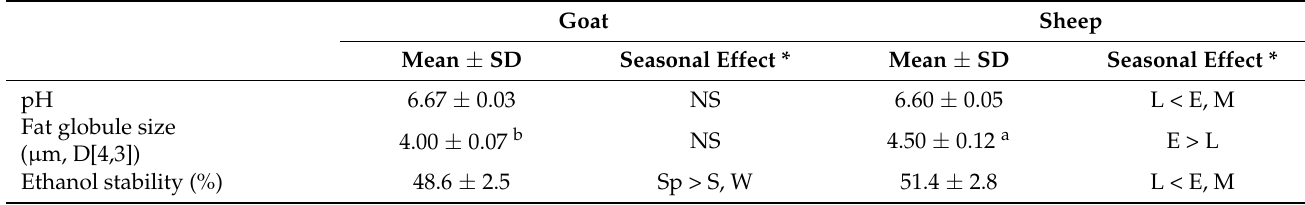
Table 4. Physicochemical properties of goat and sheep